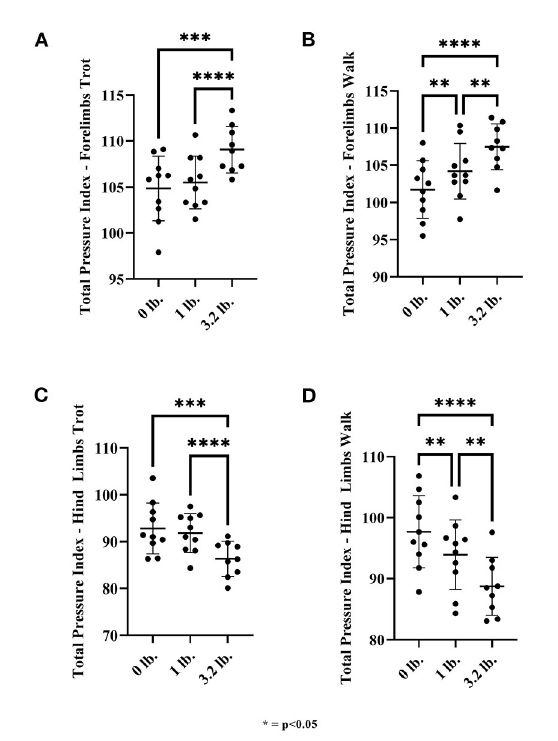
FIGURE6 Total pressure index for front and hind limbs at walk and trot. (A) Front limb trot, (B) Front limb walk, (C) Hind limb trot, and (D) Hind limb walk ( N = 10). The asterisks denote different levels of significance (* P ≤ 0.05, ** P ≤ 0.01, *** P ≤ 0.001, **** P ≤